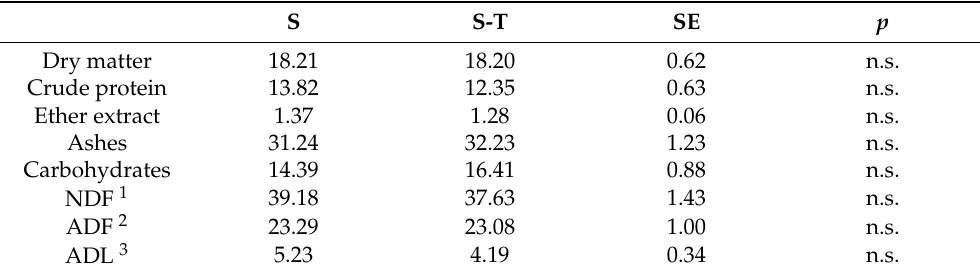
Table 2. Proximate percentage composition (g 100 g − 1 ) of the edible portion of Salicornia plants cultivated in monoculture (S) or in intercropping (S-T) with tomato plants. Data represent the mean of 4 replicates. SE, standard error. n.s. = not